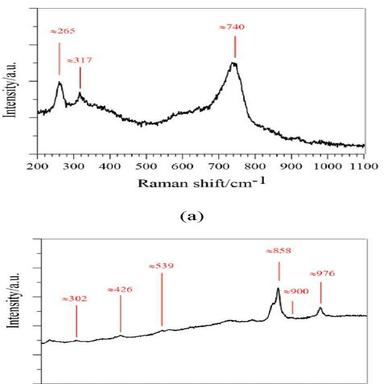
Raman spectra of (a) C4AF and (c) β-C2S identified in cracks (red cross) shown in optical micrographs (b and d) from samples with 0% CA and 1% CA,